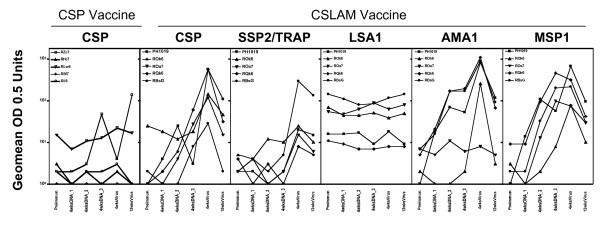
Antigen-specific antibody responses against pre-erythrocytic antigens PfCSP, PfSSP2/TRAP, PfLSA1 and blood stage antigens PfAMA1 and PfMSP1. Sera from monkeys immunized with either CSP/PBS or CSLAM/PBS were assayed against PfCSP, PfSSP2/TRAP, PfLSA1, PfAMA1 or PfMSP1 capture antigens by ELISA. Data are presented as the geometric means of titers at OD 0.5 units from individual monkeys per group. ELISA responses were classified as positive if (1) OD0.5 unit titer was > 10; and (2) the seroconversion index (ratio of titer post-immunization to titer pre-immunization) was > 4. Preimmun = preimmunization; 4wksDNA_1 = 4 wks post 1st DNA immunization; 4wksDNA_2 = 4 wks post 2nd DNA immunization; 4wksDNA_3 = 4 wks post 3rd DNA immunization; 4wksVirus = 4 wks post ALVAC-Pf7 boost; 12 wksVirus = 12 wks post ALVAC-Pf7 boost.